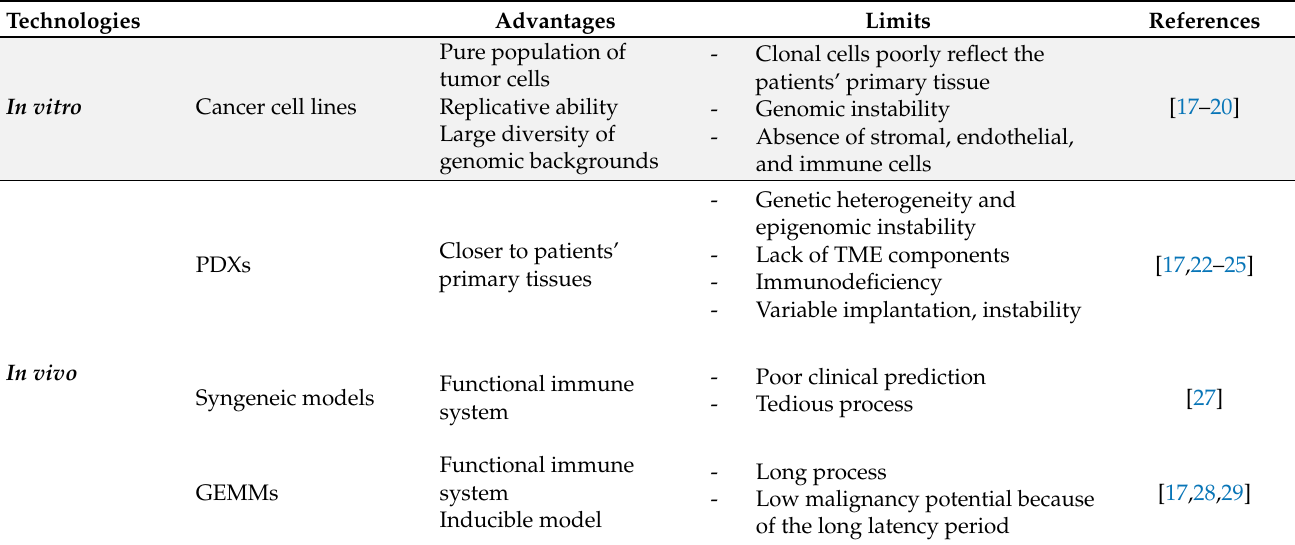
Table 1. Advantages and limits of the main preclinical lung cancer